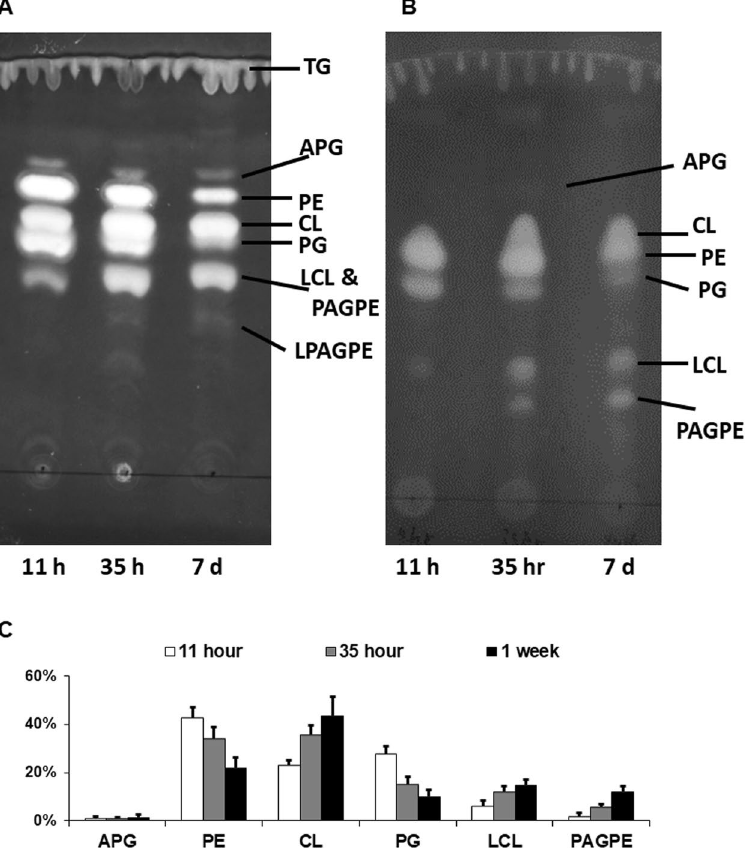
Figure 1. Thin-layer chromatogram and lipid composition of lipids extracted from A. radioresistens . TG (triglyceride), PG (phosphatidylglycerol), APG (acyl-phosphatidylglycerol), PAGPE (1-phosphatidyl-2-acyl- glycero-3-phosphoethanolamine, PE (phosphatidylethanolamine), CL (cardiolipin) and LCL (lysocardiolipin) were separated by TLC (thin-layer chromatography). ( A ) Thin-layer chromatogram developed in 75:25:4 chloroform/methanol/water. ( B ) Thin-layer chromatogram developed in 75:25:3:1 chloroform/methanol/water/ acetic acid (glacial). The TLC sheets were stained with 0.02% primuline in 80:20 acetone/water. Representative fluorescent bands were analyzed by MS for identification. The lipid compositions are marked on the right. TG was likely diffused along the solvent front. ( C ) Semi-quantitative estimate of lipid composition based on primuline